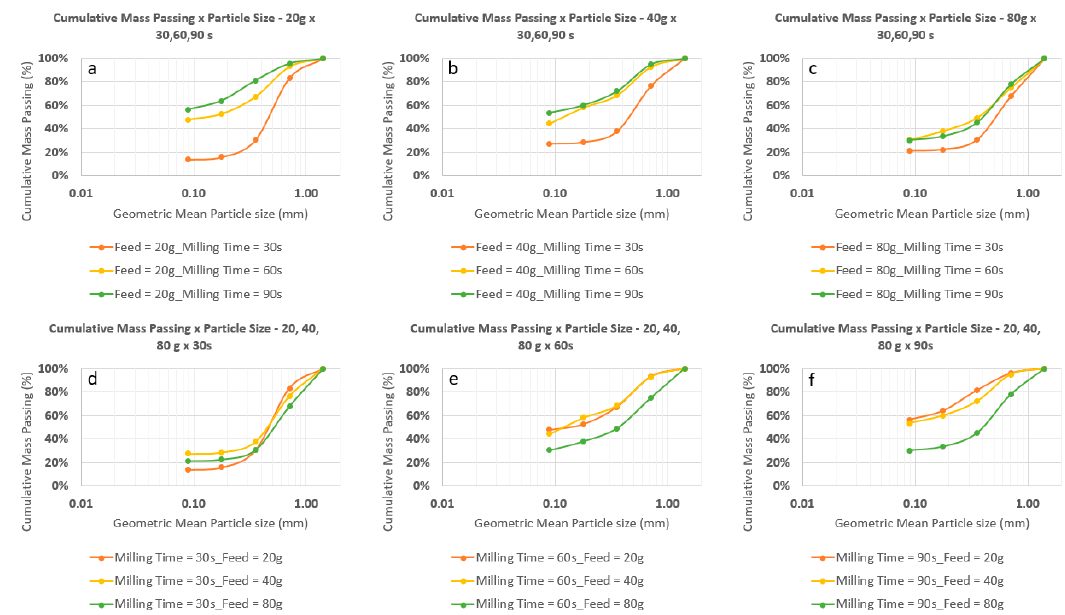
Figure 2. Particle size distribution of hammer mill products from 1–2 mm feed. ( a ) 20 g feed, ( b ) 40 g feed ( c ) 80 g feed, ( d ) 30 s milling time, ( e ) 60 s milling time, and ( f ) 90 s milling time.